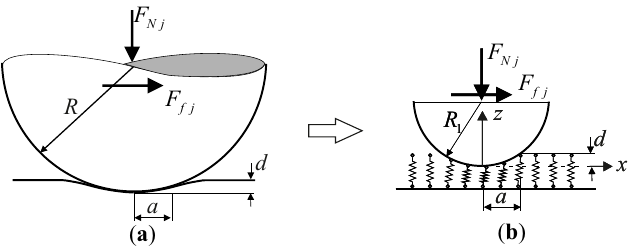
Figure 4. Microscopic model: ( a ) three-dimensional Hertzian contact between a hemisphere and the runner; ( b ) one-dimensional equivalent contact with elastic foundation